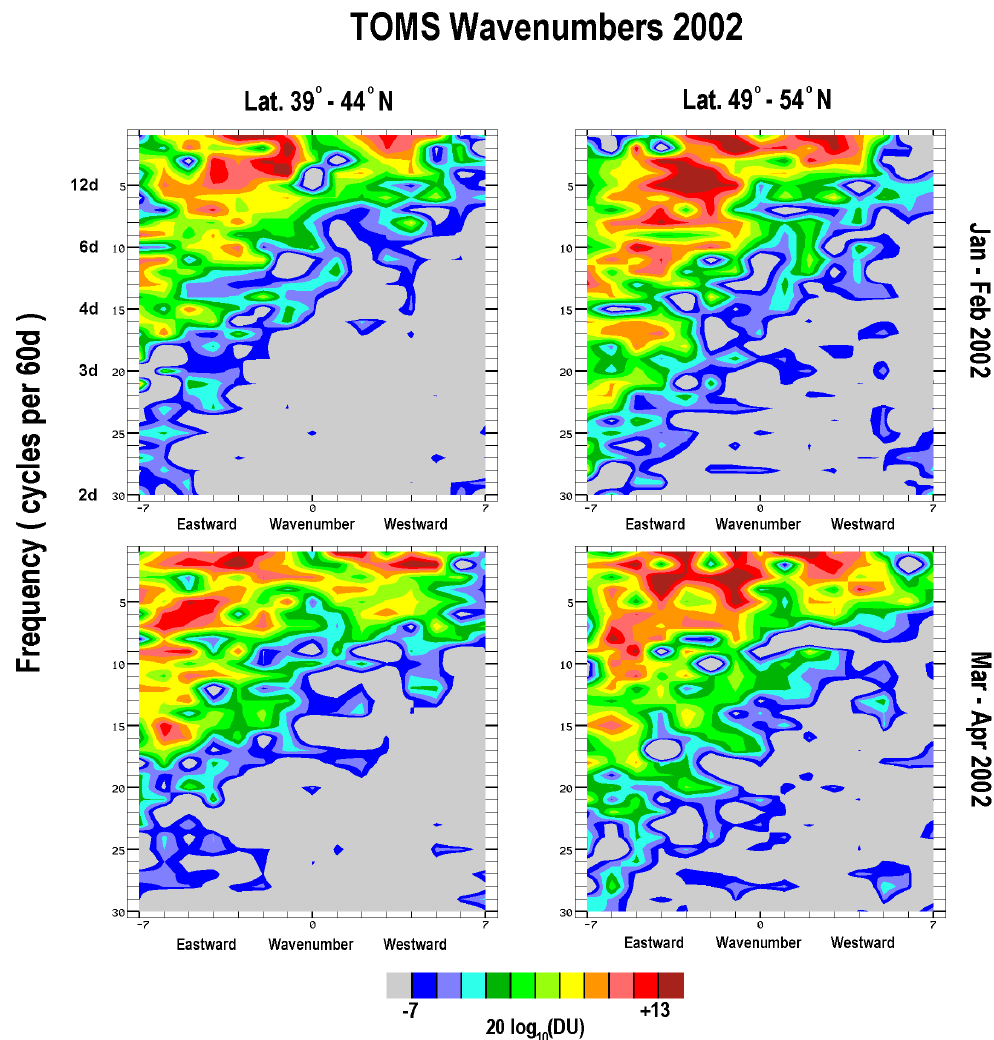
Fig. 8. TOMS wave number spectra for two latitude bands during the days 61–120 of 2001. The full set of available longitudes is used for these